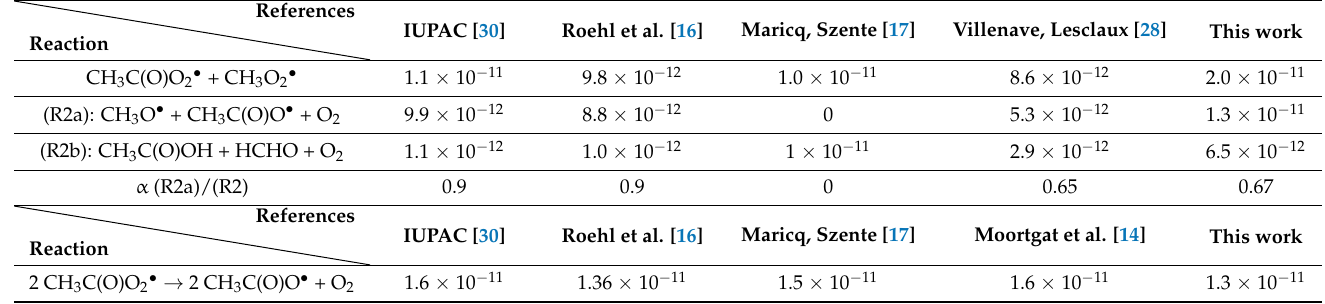
Table 1. Summary of literature results for (R1) and (R2), all rate constants in cm 3 s − 1